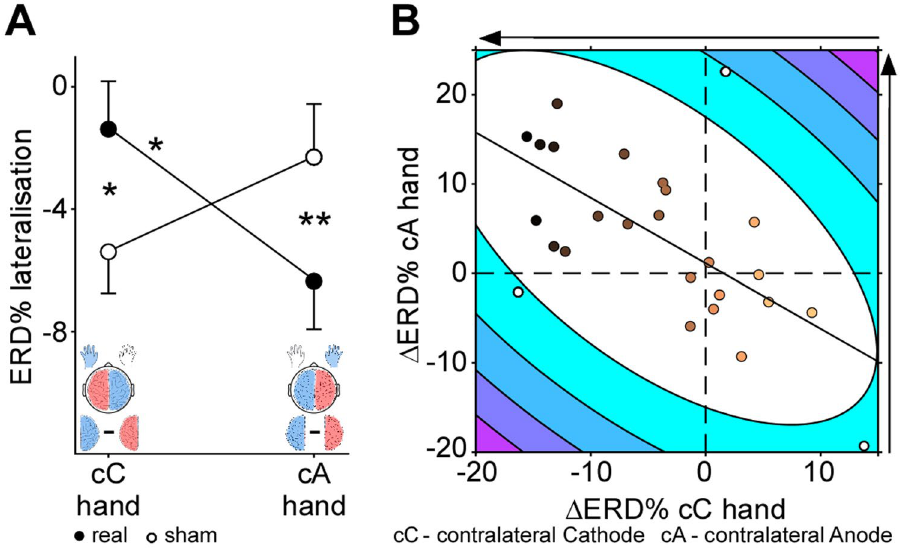
Figure 3. Interferential statistics of stimulation-induced changes on neural level. ( A ) Interaction between stimulation type and hand considering the degree of MI-induced ERD% lateralization. Error bars represent one standard error. * p < 0.05, ** p < 0.01. ( B ) Association of MI-induced Δ ERD% lateralization between both hands. Contour lines represent the bootstrapped Mahalanobis distance from the bivariate mean in steps of six squared units (purple colours indicate greater distance). White circles represent outliers. Darker colours of the other circles denote greater sensitivity to stimulation. The horizontal dashed lines mark zero and the solid line is the linear regression over the data after outlier removal. Direction of the arrows indicates the predicted stimulation-related change.